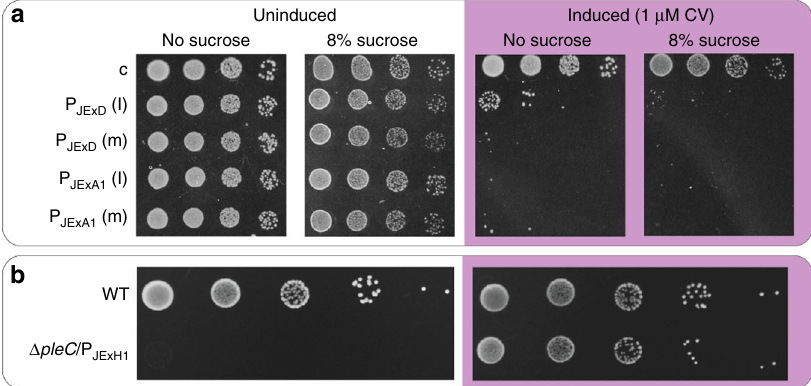
Fig. 5 Tight regulation enables control of toxic and essential genes in E. coli and S. meliloti . a Ten-fold serial dilutions of E. coli expressing the toxic gene sacB from P JExA1 and P JExD located either on low (l) or medium (m) copy-number plasmids, grown under repressed conditions or induced by 1 µ M CV. A strain lacking sacB (c) was used as control. Induction caused sacB expression at levels that were toxic in the absence of sucrose or in the presence of high sucrose concentrations. Note that unlike in sacB counterselection plasmids, the P JEx plasmids do not include the native B. subtilis 5 ′ region, which contains a terminator element that is neutralized by a sucrose-inducible antiterminator 72 . b Ten-fold serial dilutions of either S. meliloti wild type (WT) or a Δ pleC mutant with a plasmid-borne sole copy of the essential cell cycle regulator gene pleC driven by P JExH1 ( Δ pleC/ P JExH1 ). Strains were plated under repressed conditions or induced by 1 µ M